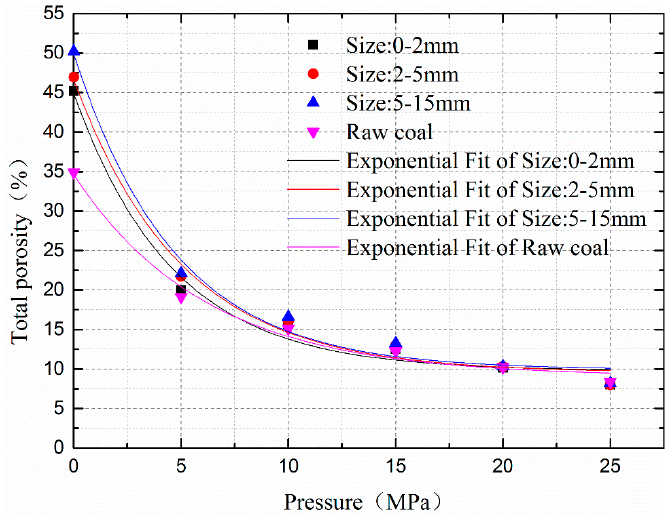
Figure 10. Curves of total porosity change with increasing pressure for specified particle size classes.